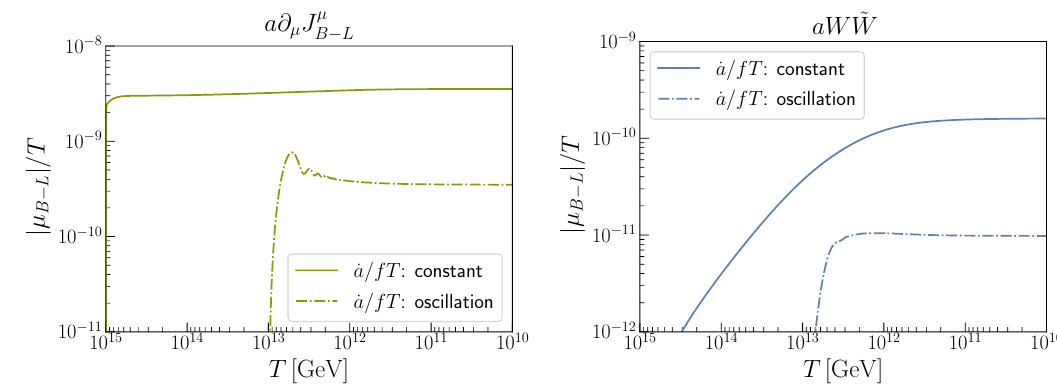
Figure 3 . The time evolution of the B L asymmetry produced from the shift-symmetric coupling (cid:0) ( a=f ) @ (cid:22) J (cid:22) (left panel) and ( a=f ) W ~ W (right panel) for constant _ a= ( fT ) (solid) and oscillating B (cid:0) L _ a= ( fT )